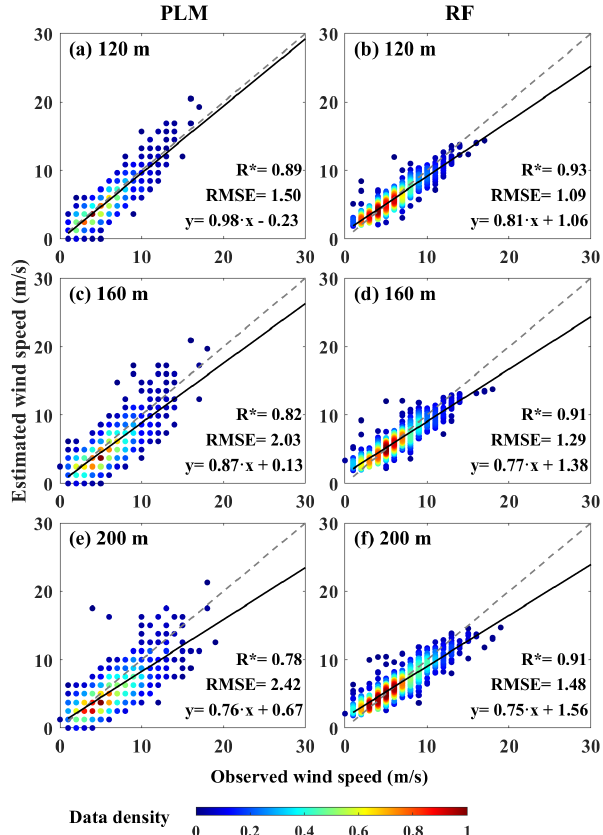
Figure 5. Comparisons between observed wind speed and esti- mated wind speed for (a, c, e) the PLM and (b, d, f) RF at 120, 160, and 200m. The gray and black lines are the reference and regres- sion lines, respectively. The color bar represents the data density. The asterisk indicates that the correlation coefficient ( R ) has passed the t test at a confidence level of